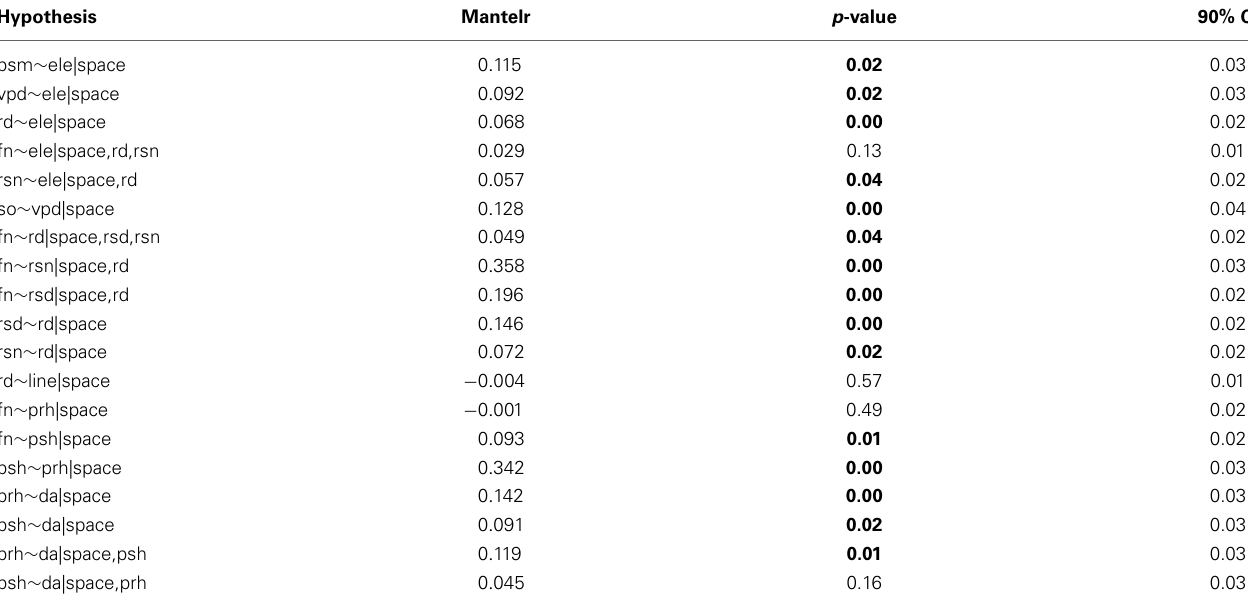
Table A1 | Hypotheses derived from correlograms and simple Mantel tests, and tested by using partial Mantel tests.